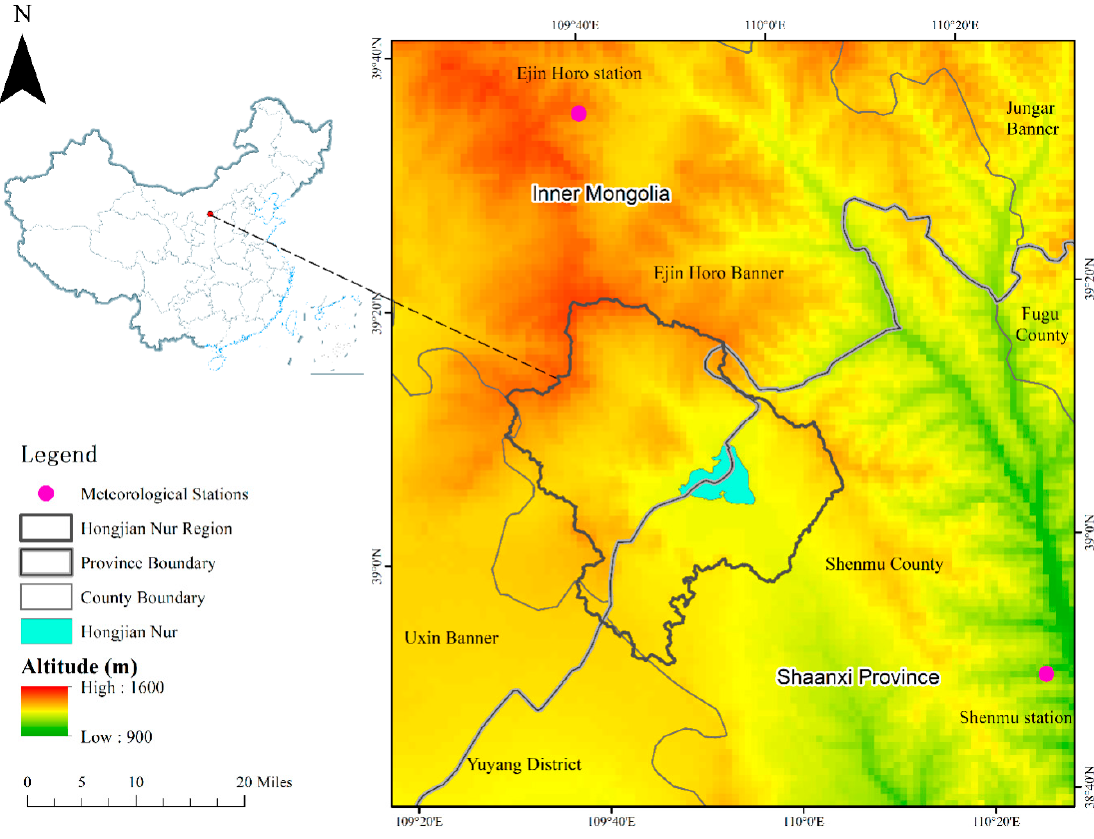
Figure 1. Study area. In the figure, the elevation increases gradually from blue to brown. Blue is low and brown is high.